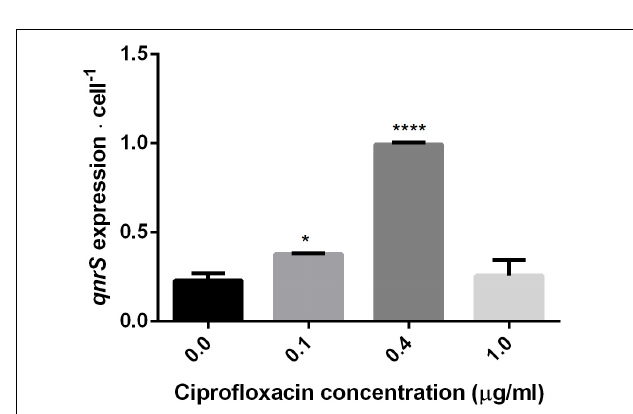
FIGURE 3 | Quantification of qnrS transcripts normalized to estimated bacterial cell number at mid-log phase under different ciprofloxacin concentrations (0, 0.1, 0.4, and 1.0 µ g ml − 1 ). Cells grown in 0 and 0.1 µ g ml − 1 ciprofloxacin were harvested after 2.5 h; cells grown in 0.4 µ g ml − 1 ciprofloxacin were harvested after 6 h; and cells grown in 1.0 µ g ml − 1 ciprofloxacin were harvested after 7 h. The reported significance refers to a ∗ p -value < 0.05 for 0.1 µ g ml − 1 , and a ∗∗∗∗ p -value < 0.0001 for 0.4 µ g ml − 1 .